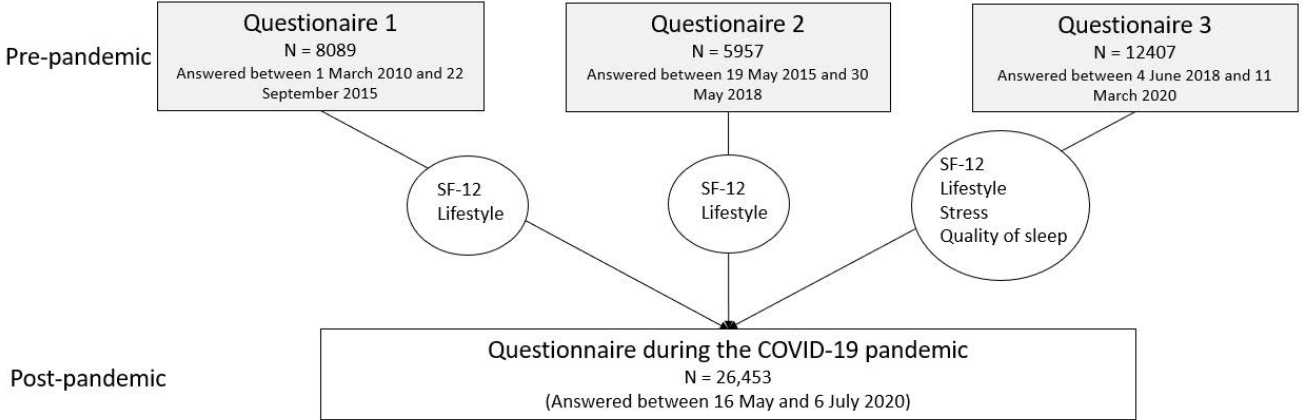
Figure 1. Overview of included questionnaires.